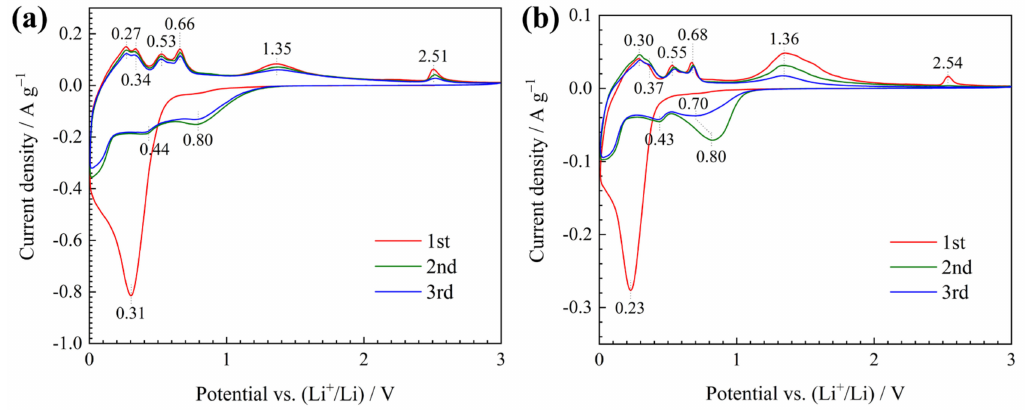
Figure 3. Cyclic voltammetry (CV) curves of ( a ) ZnO / Ni and ( b ) ZnO electrodes.